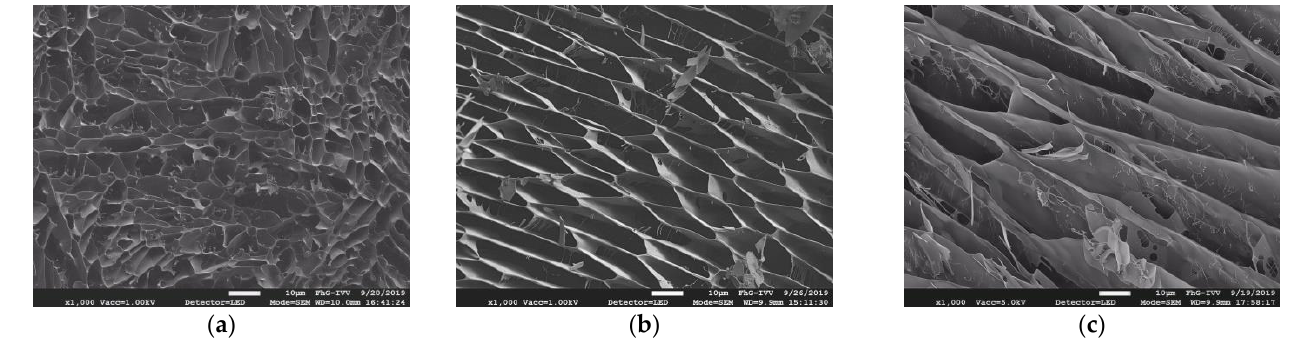
Figure 7. Cryo scanning electron microscope images of the three CMC solutions in their highest concentration of 3.5 × c* at the same scale and a magnification of 1000: 4.5 g/100 g CMC-L ( a ), 1.5 g/100 g CMC-M ( b ) and 0.8 g/100 g CMC-H ( c ).